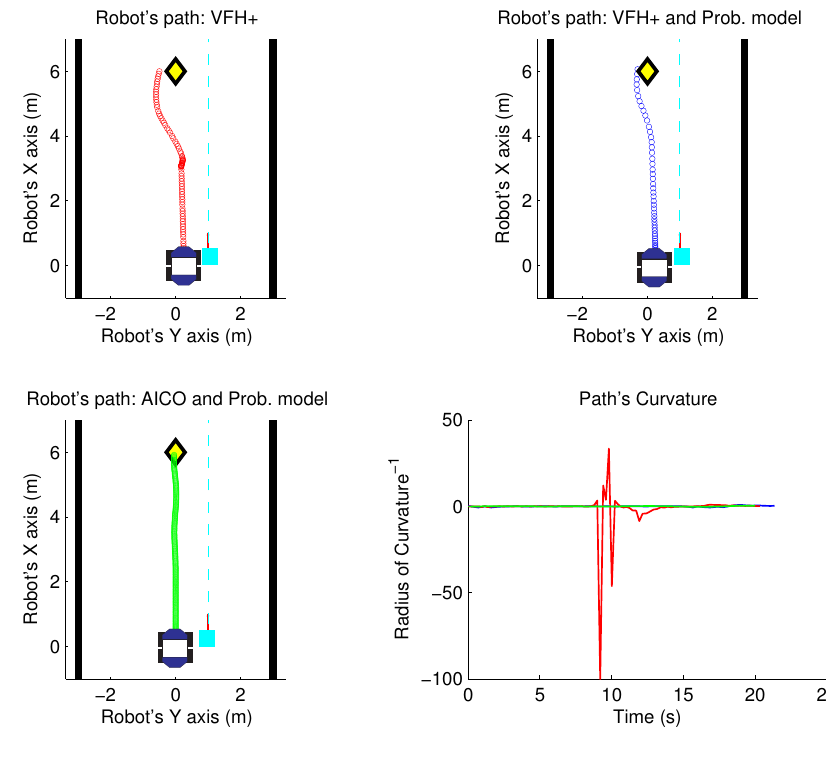
Figure 8. Path using VFH+ and AICO: parallel scenario.